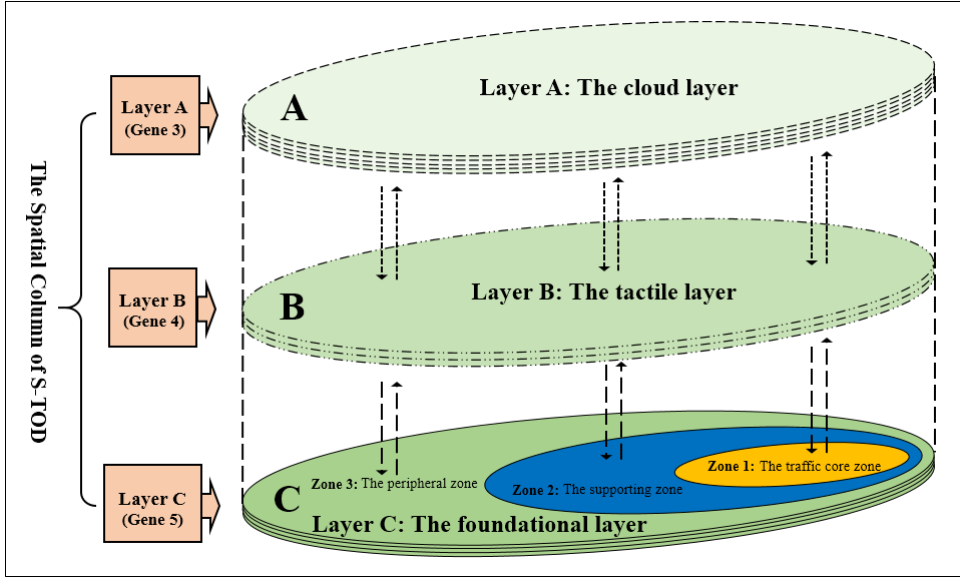
Figure 13. The columned structure of S-TOD.